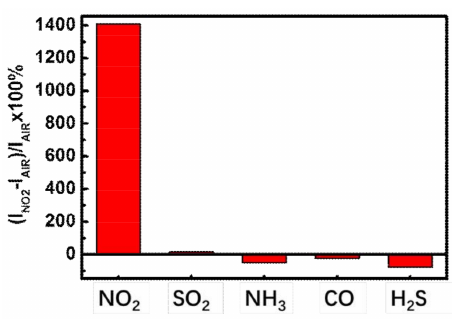
Figure 6. Drain current changes for perpendicular device exposed to different gases.